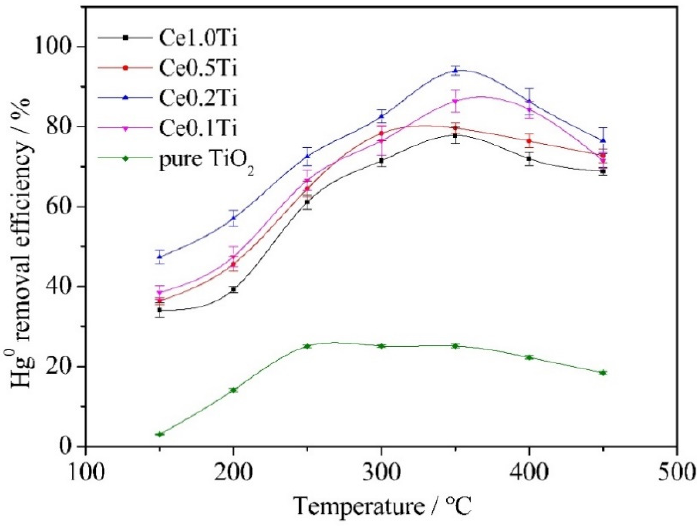
Figure 3. The e ff ect of reaction temperature on catalytic Figure 3. The effect of reaction temperature on catalytic performance.